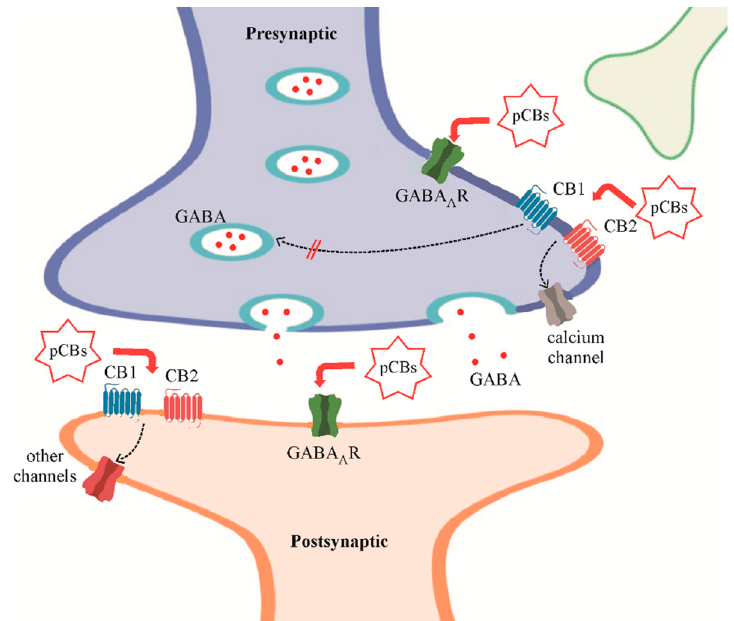
Figure 1. The major phytocannabinoids tetrahydrocannabinol (THC), cannabidiol (CBD), and cannabidivarine (CBDV) (phytocannabinoids—pCBs) can modulate γ -Aminobutyric acid type A receptors (GABA A Rs) both directly [33,61] and through the activation of cannabinoid receptors 1 (CB1) and 2 (CB2) [66]). As shown, pCBs targets are located both at the presynaptic and postsynaptic terminals. In detail, pCBs can modulate GABA release by acting on presynaptic CBRs and enhance the postsynaptic GABAergic activity by potentiating GABA A R currents.